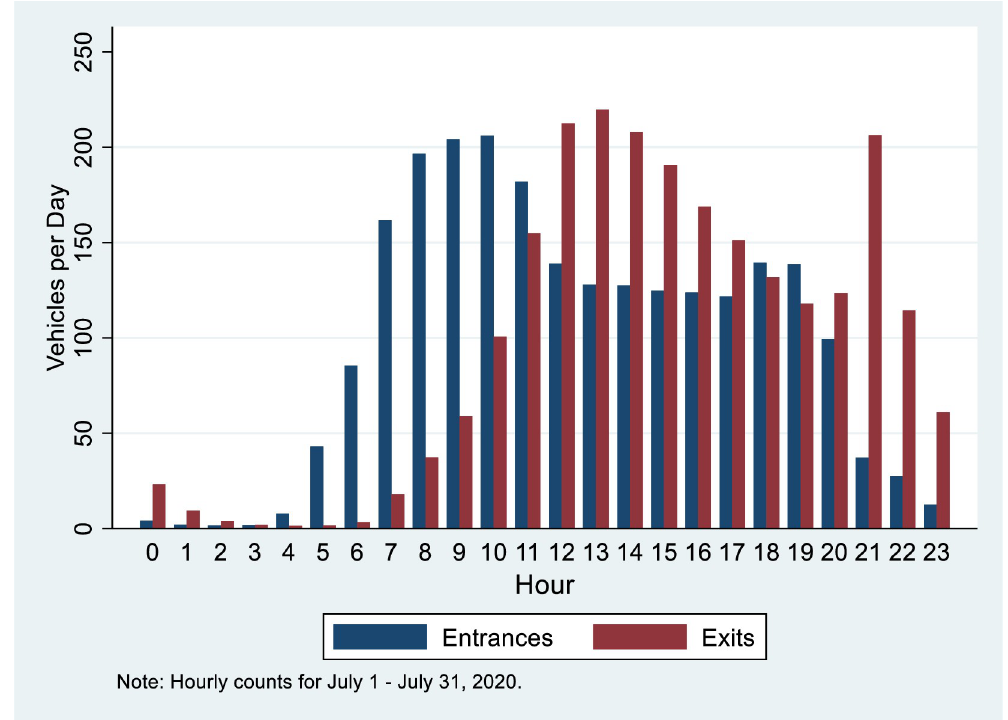
Fig 2. Entrance and exit data for Arches National Park.